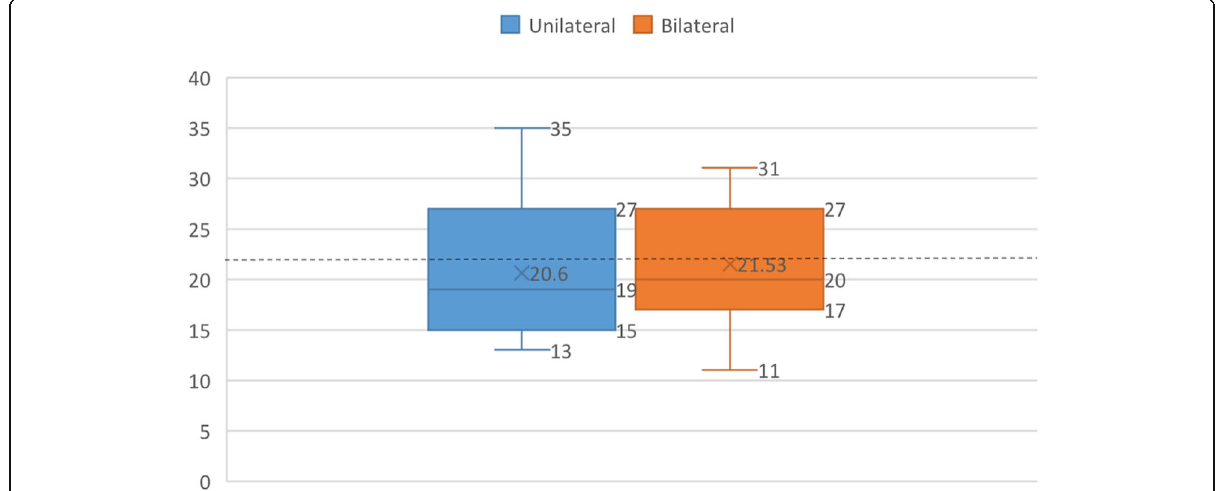
Fig. 5 Box plots of the touch processing section in children with unilateral and bilateral